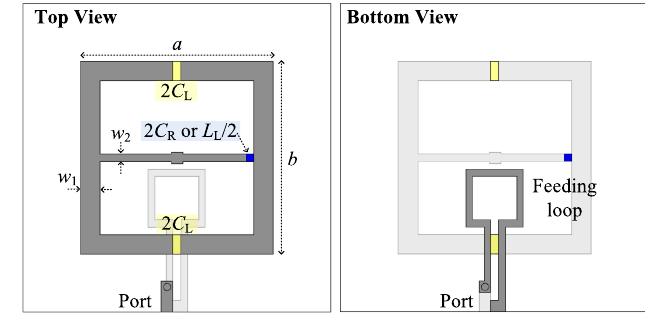
Fig. 10. Structure of the